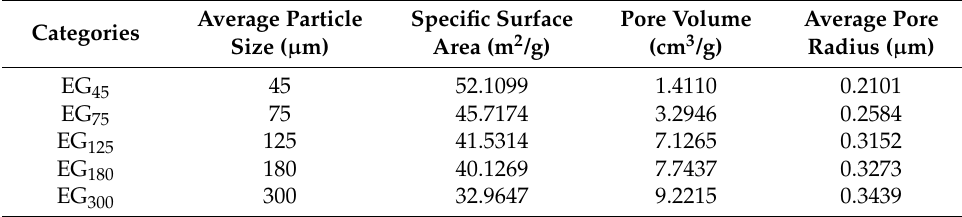
Table 2. Basic properties of expanded graphites (EGs) used in this